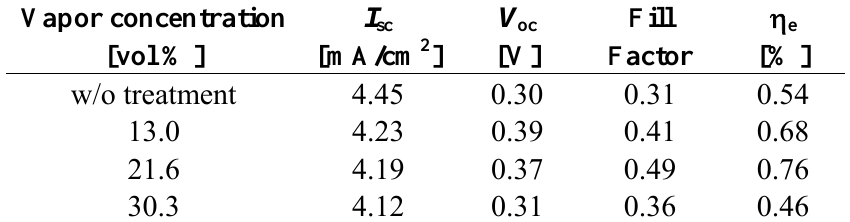
Table 1. Performance parameters in current-voltage characteristics of the solar cells under AM1.5 solar-illuminated conditions depending on the vapor concentration at 25 °C in the